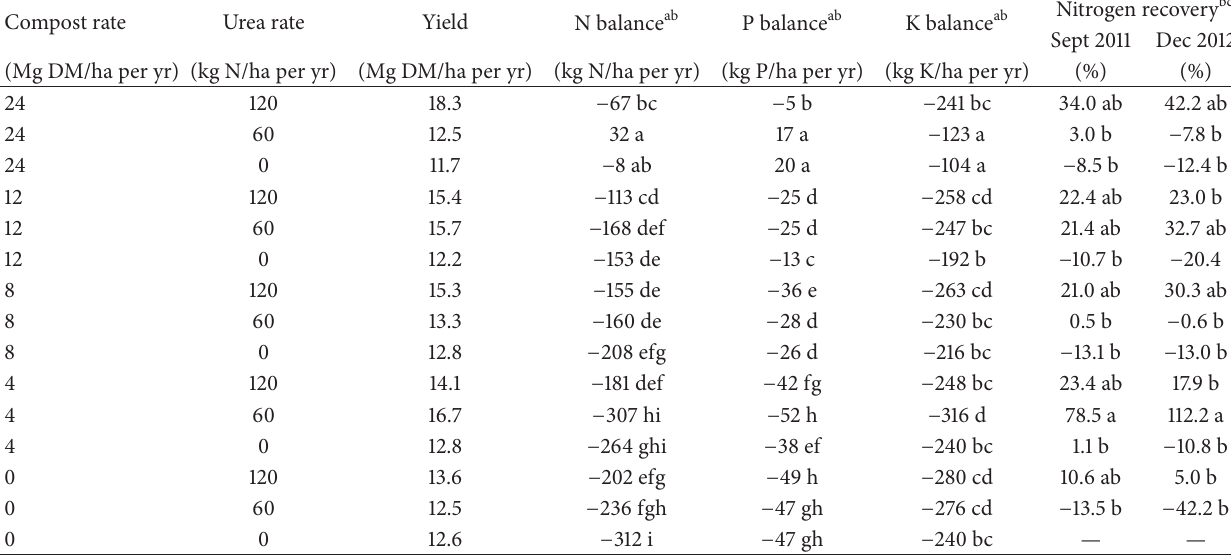
a Balances were calculated using overall dry matter yield treatment means and plot treatment nutrient concentrations from September 2011 and December 2012 samples. b Means not connected by the same letter in each column are significantly different ( 𝑃 ≤ 0.05 ).